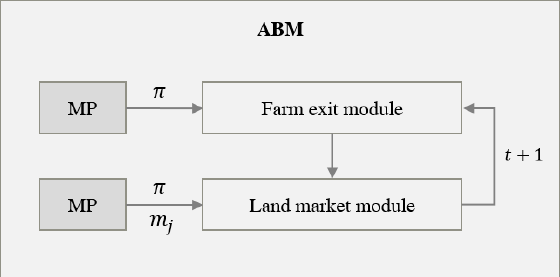
Figure 1. Classical set-up of an ABM integrating